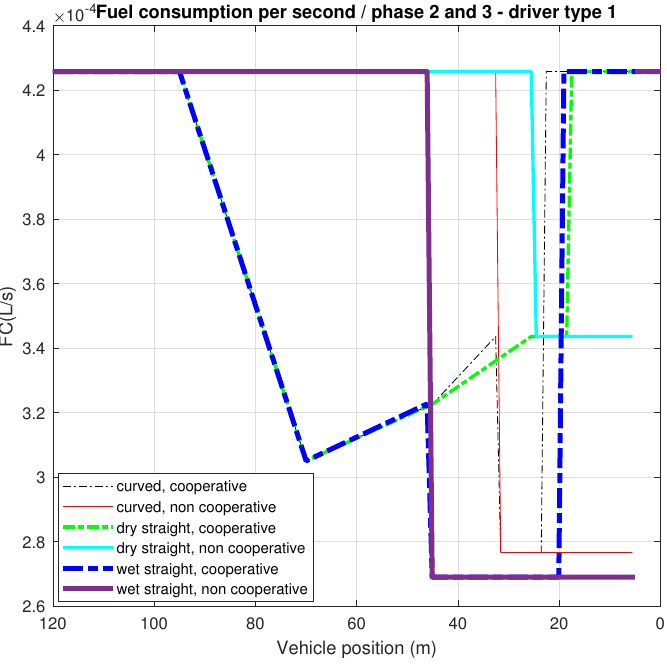
Figure 16. Instantaneous fuel consumption during phases 2 and 3, for driver type